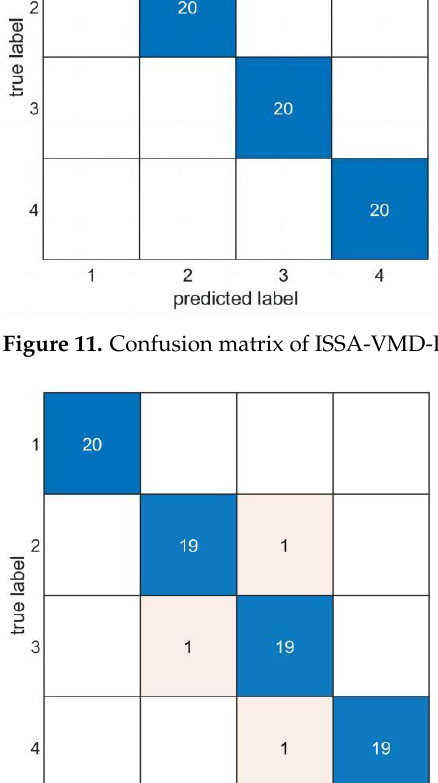
Figure 13. Confusion matrix of ISSA-VMD-FCM. In order to improve the confidence in the results, the experiments were repeated ten times to take the average identification accuracy for comparison. Every time, the training set and test set were randomly divided. The results are shown in Table 5. Table 5. Average accuracy of different classifiers. Classifier